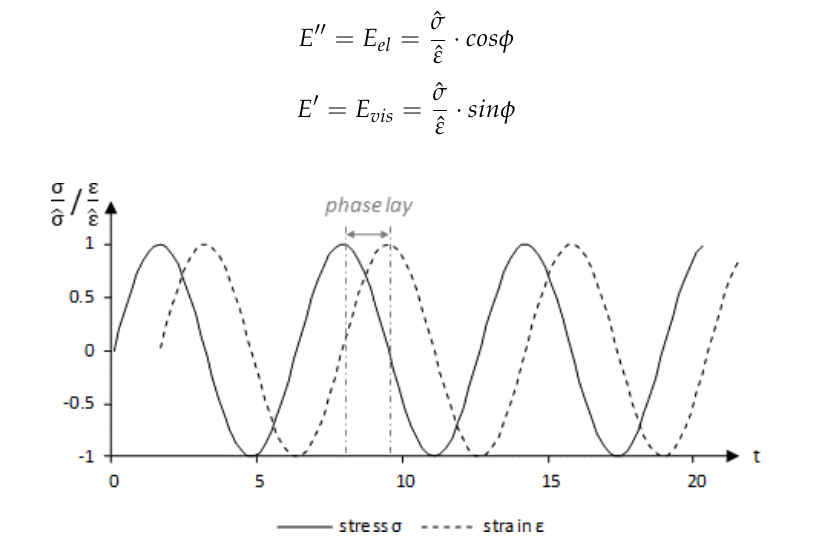
Figure 5. Sinusoidal loading according to